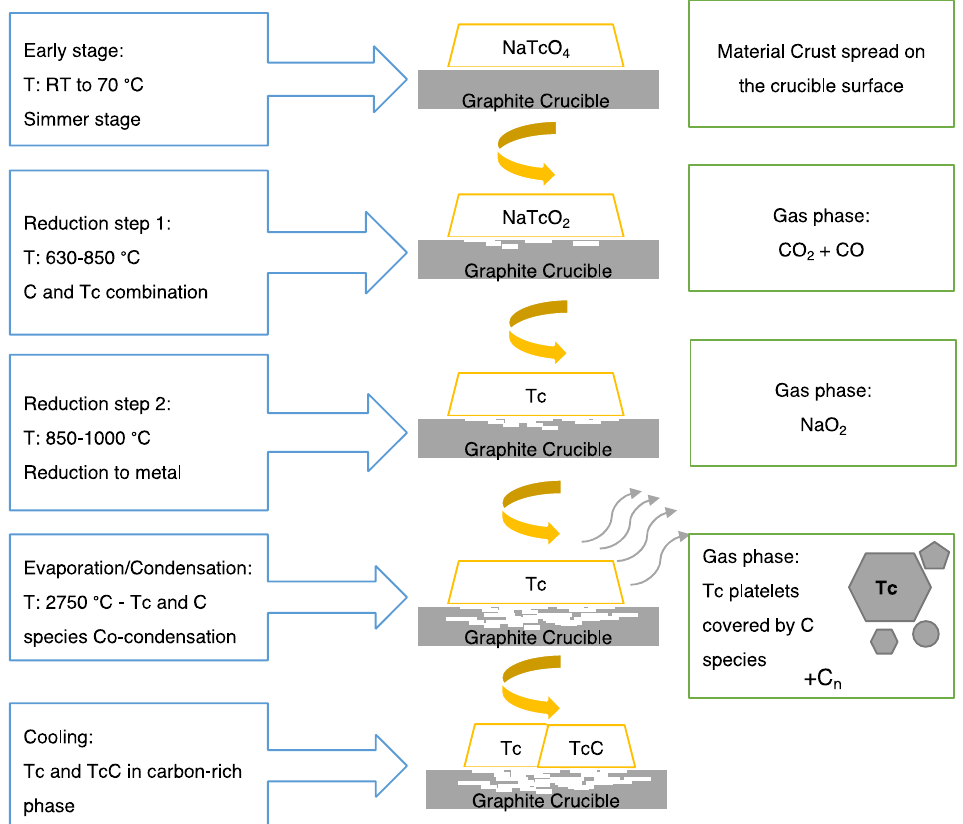
Figure 5. A schematic illustration represents the proposed Technegas production mechanism. Mod- i fi ed from the original study of potassium pertechnetate. Reprinted/adapted from Ref. [ 7